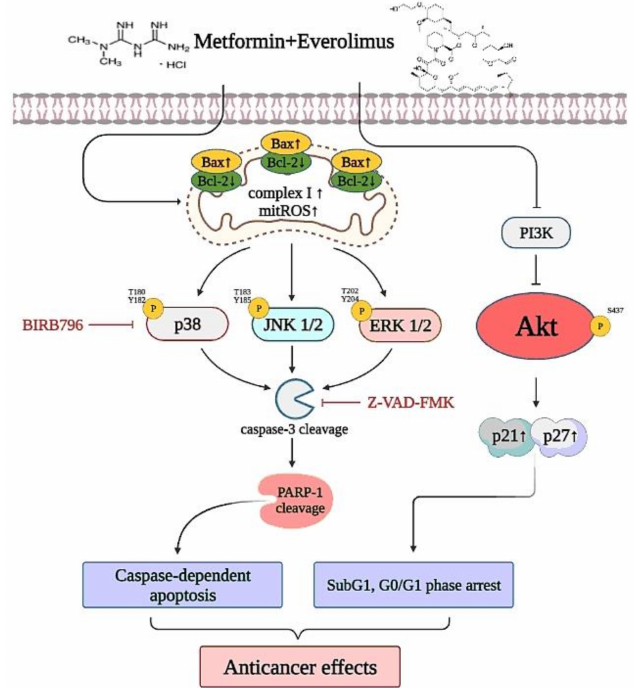
Figure 9. Anticancer molecular mechanism of metformin combined with everolimus in cervical cancer treatment. Metformin sensitizes everolimus, which mainly modulates MAPKs (p38, ERK, and JNK) upregulation and PI3K/AKT downregulation, activating or inactivating various signaling targets, such as Bax, Bcl2, caspase-3, PARP-1, Complex I, mtROS, p21, and p27. The activation and inactivation of these signaling pathways induced subG1- and G0/G1-phase arrest and caspase- dependent apoptosis, which increase the anticancer effects on cervical